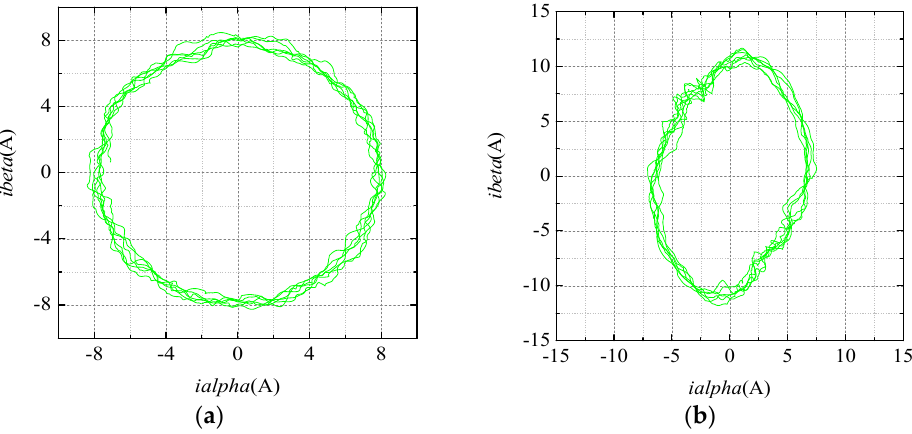
Figure 3. Control system of DTP-PMSM. Figure 4a shows the current trajectory curve in α - β subspace. It is approximately circular when the motor operates healthily, which is consistent with (10). In the open circuit fault state, the current trajectory is no longer circular, as shown in Figure 4b.